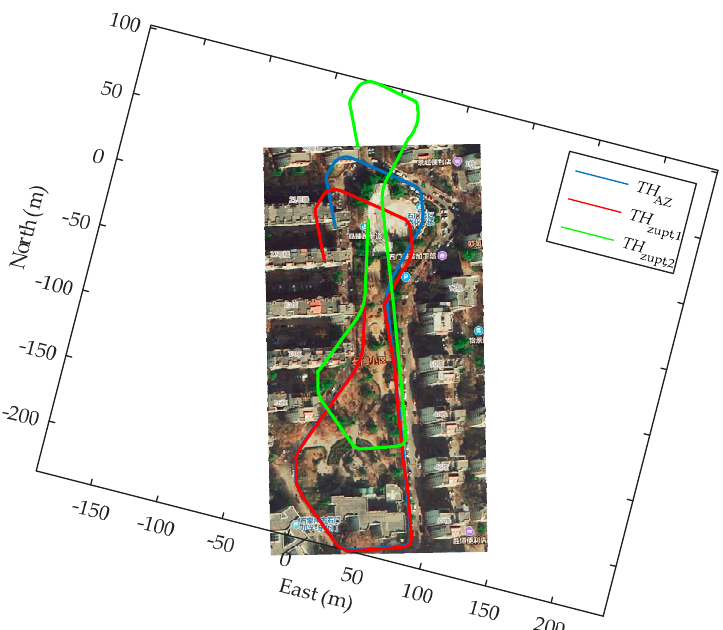
Figure 16. Comparison of the resulting 2D trajectories using adaptive and fixed threshold-based ZUPT methods.